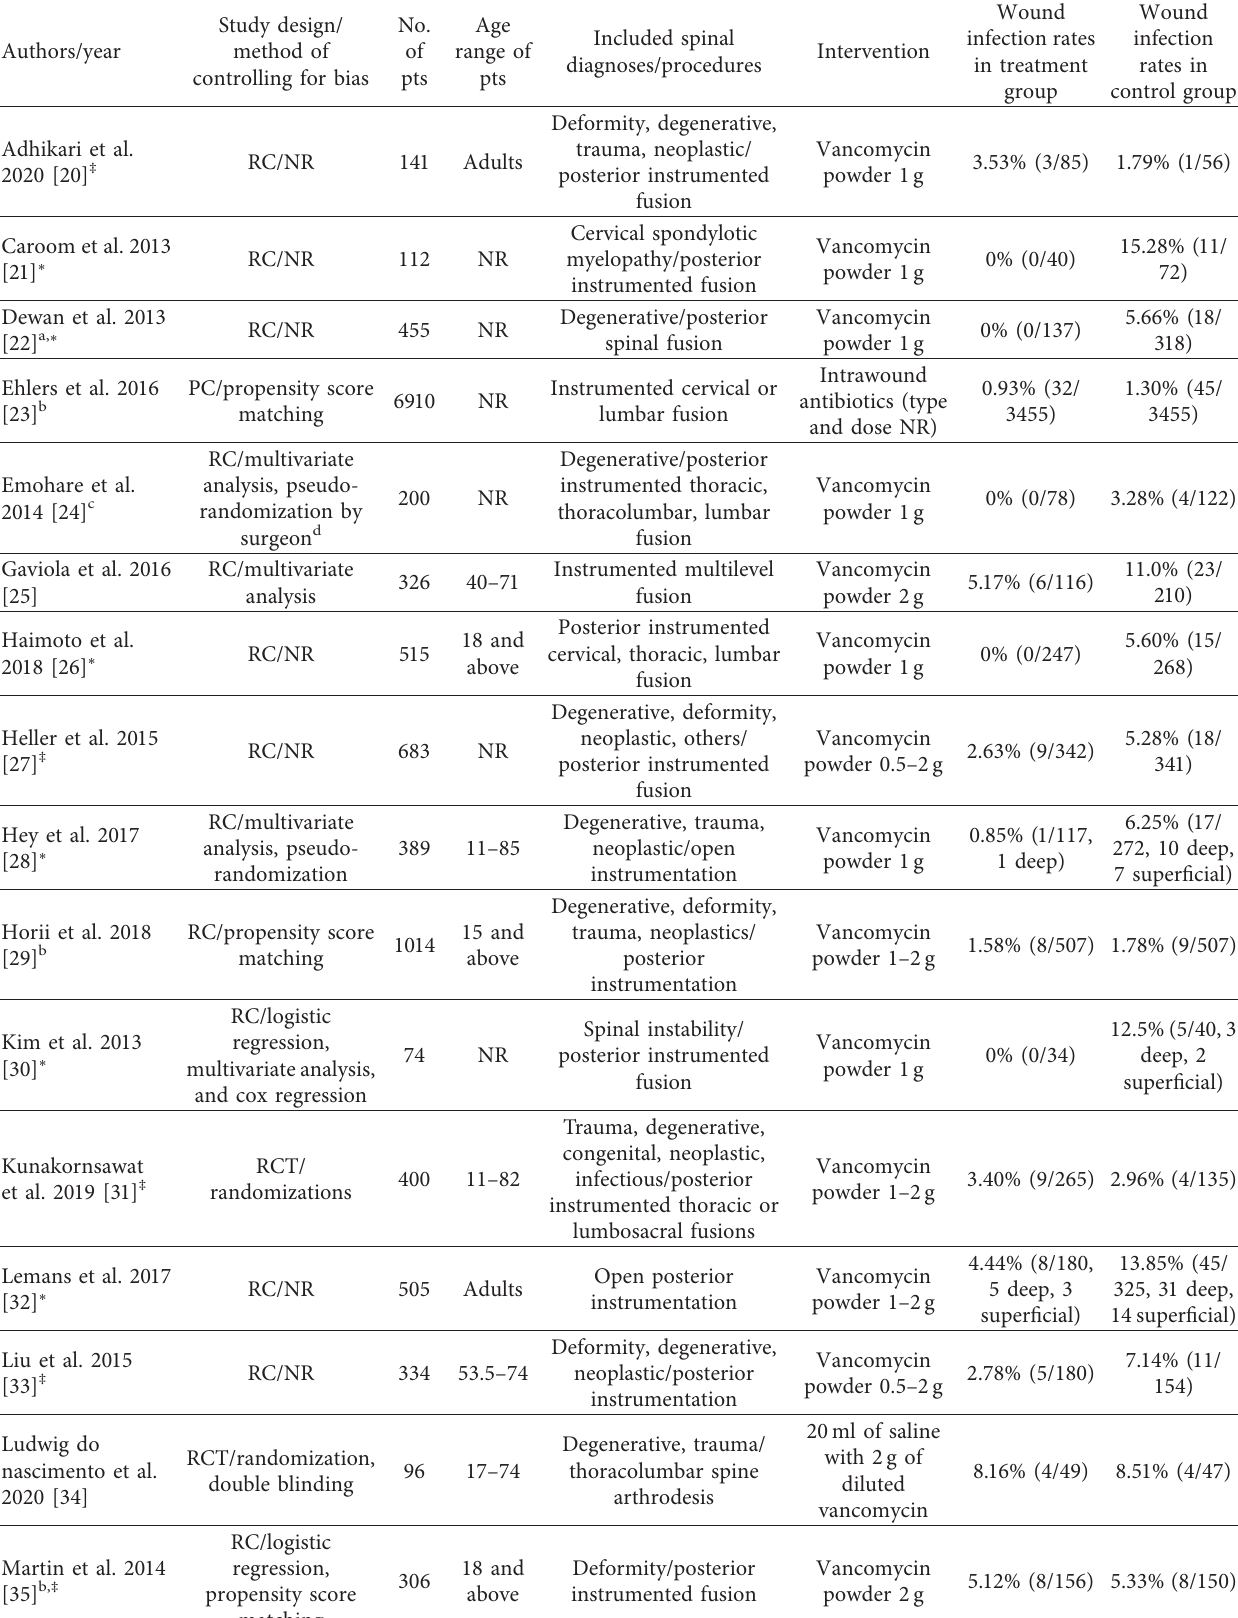
Table 1: Summary of infection rates and methodology of studies of instrumented spinal